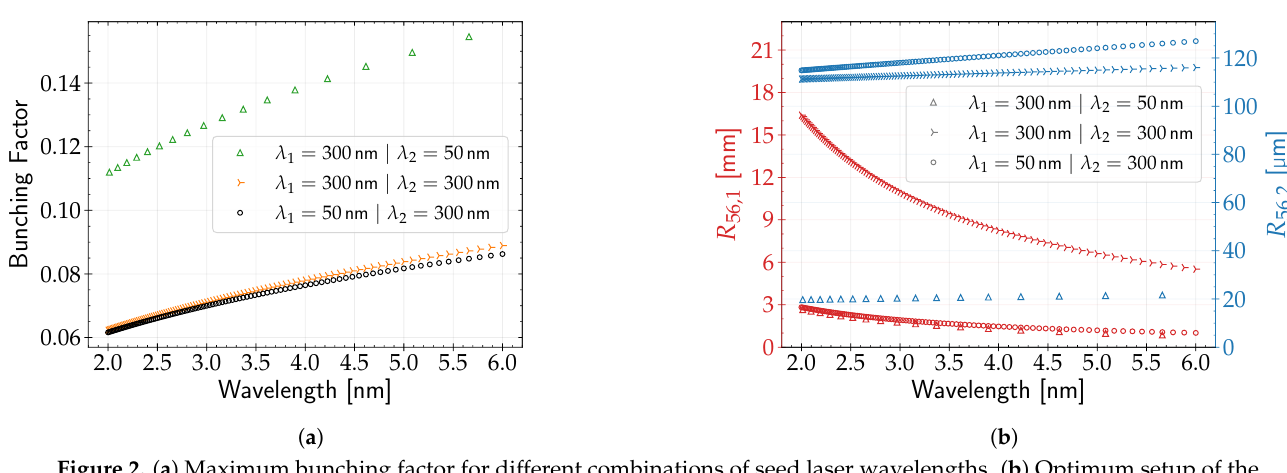
Figure 2. ( a ) Maximum bunching factor for different combinations of seed laser wavelengths. ( b ) Optimum setup of the chicanes to maximize the bunching factor. The working point resulting in a lower R 56,1 is shown for each configuration.